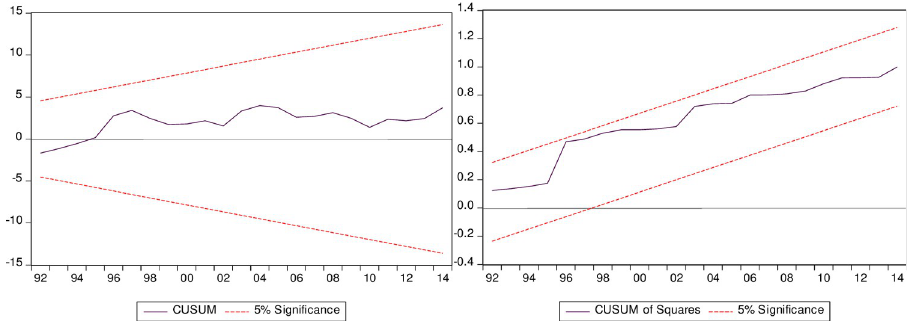
Fig 6. Cusum and Cusum Squares